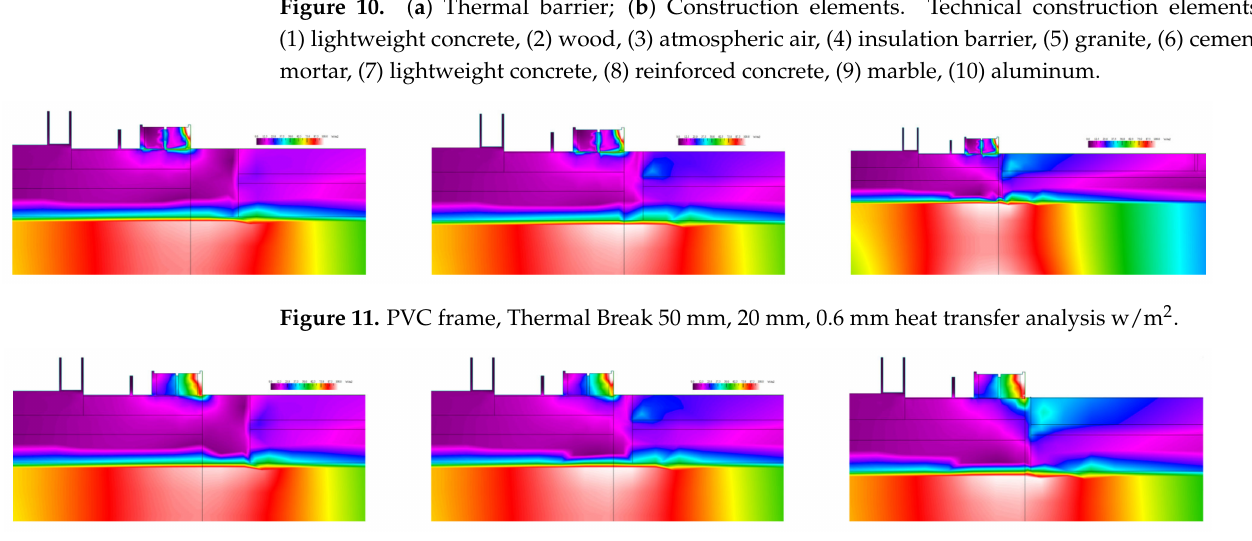
Figure 12. Wooden frame, thermal break 50 mm, 20 mm, 0.6 mm heat transfer analysis w/m 2